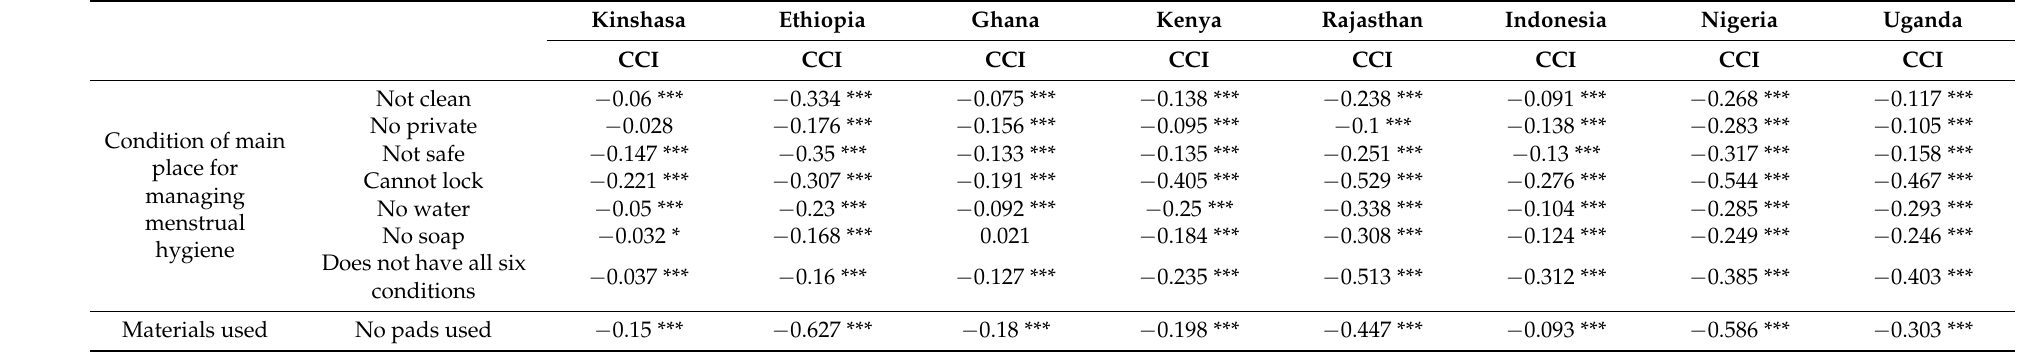
Table 3. Wealth-related inequalities in MHM: Evidence from